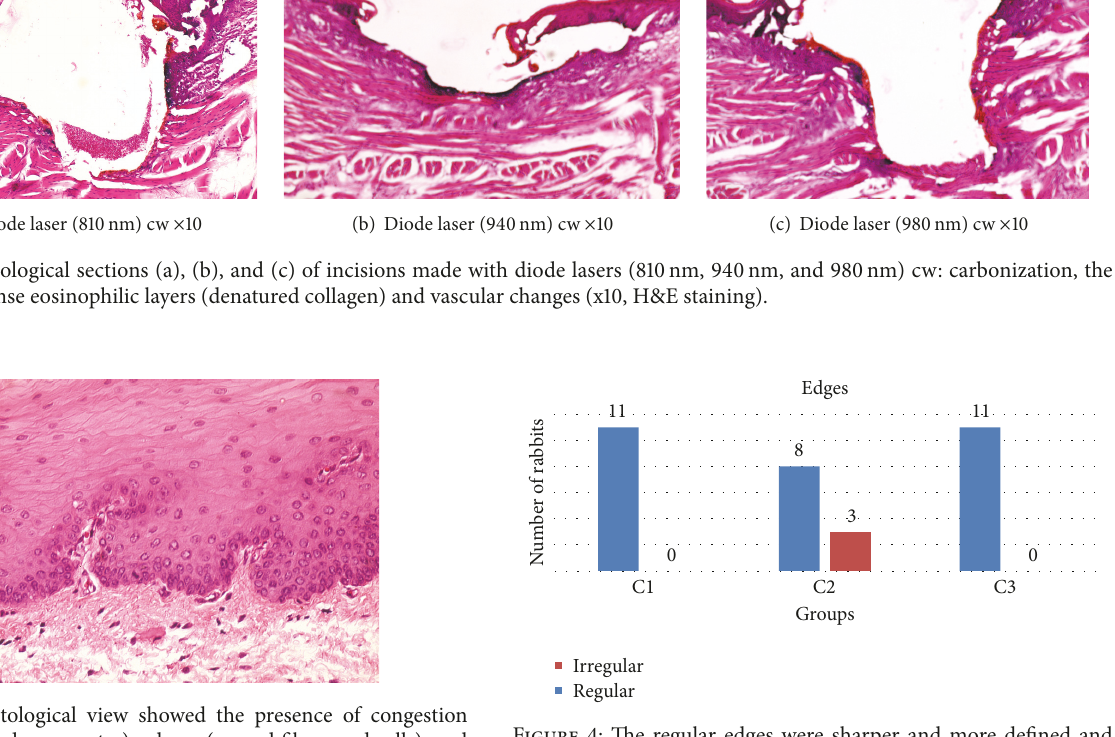
Figure 4: The regular edges were sharper and more defined and straight in C1 and C3 groups in continuous mode unlike the jagged edges in continuous mode in C2